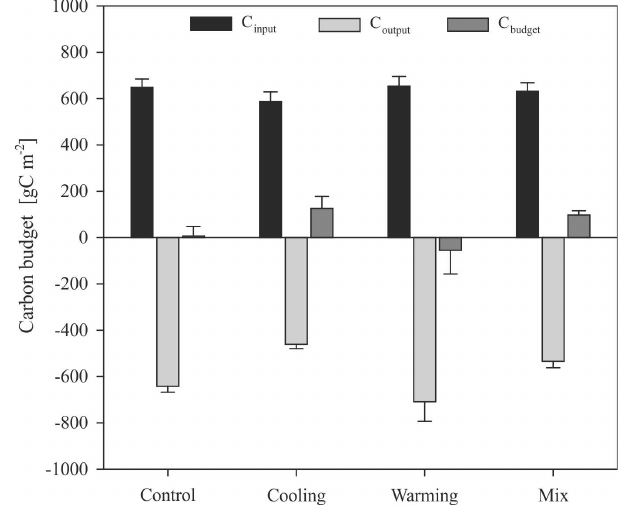
Fig. 3. Total carbon input (C input ) , carbon output (C output ) and car- bon budget (C budget ) of the studied agroecosystem. Negative values represent carbon losses. Vertical bars represent the standard error ( n =